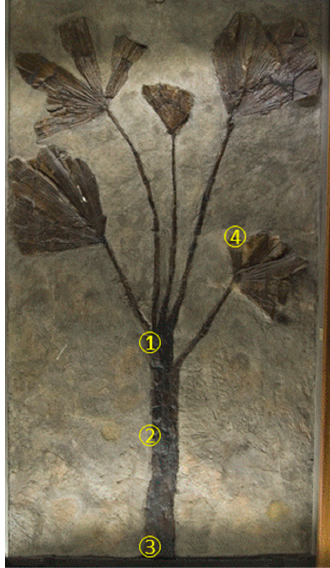
Figure 2. Picture of the Latanites sp. fossil palm with the indication of the sampling